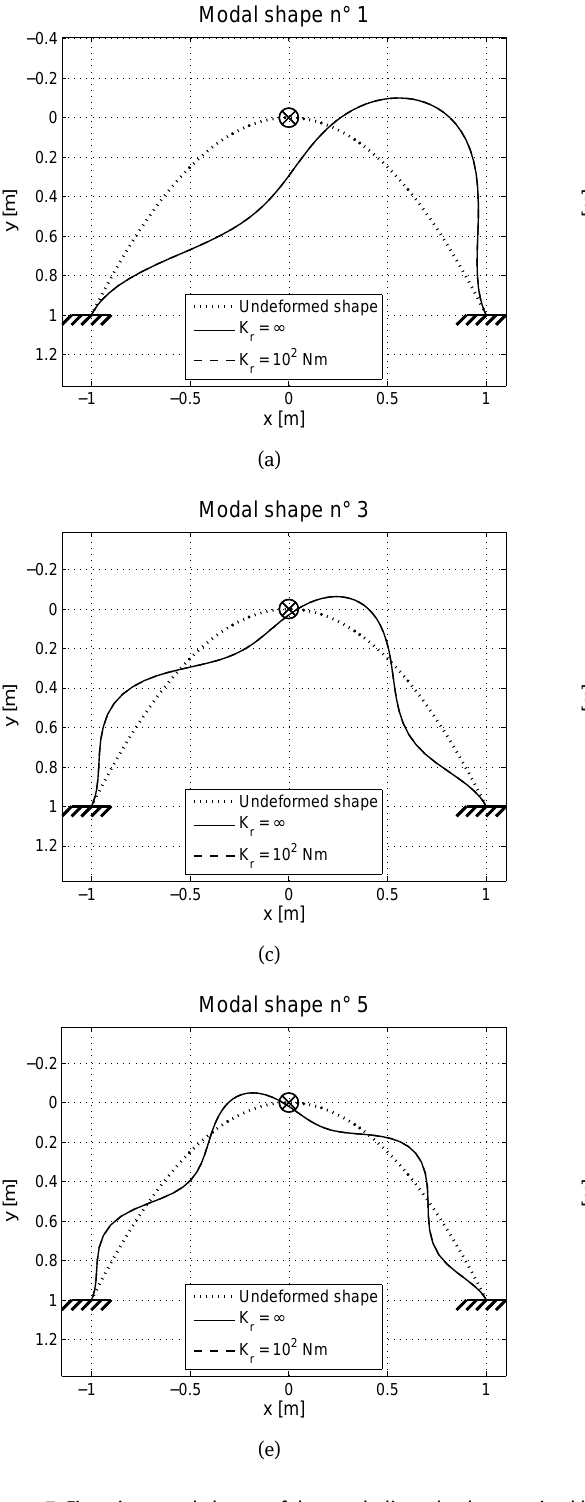
Figure 7: First six normal shapes of the parabolic arch, characterized by the two values of the rotational stiffness: K r = ∞ and K r = 10 2 Nm, with the discontinuity located in the key